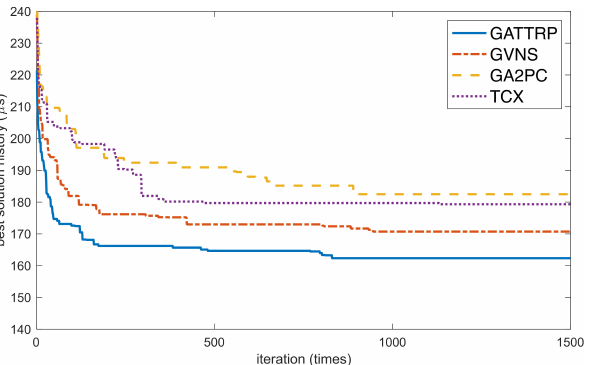
Figure 14. Convergence curves of the four algorithms when solving the same MTSP